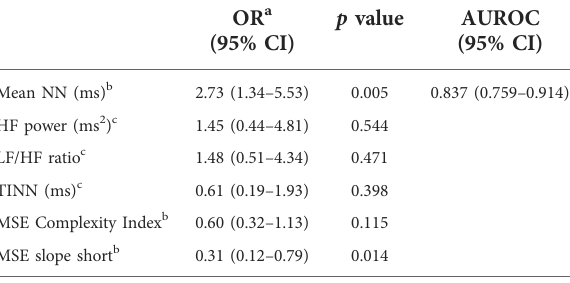
TABLE 5 Clinical multivariable analysis (clinical prediction model), n = 101 infants.